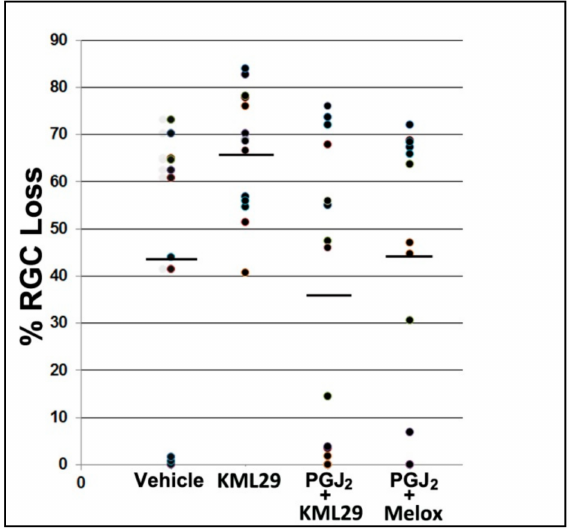
Figure 5. Stereological analysis of RGC loss following rAION induction and treatment. Scatter plot results of Brn3a(+) flat-mounted RGCs 30 d post-rAION induction. Each point represents the RGC loss from one animal compared with the contralateral (uninduced) eye (=100%). Mean RGC loss in the vehicle group was 44.0 ± 9.8% sem. KML29 treatment alone (no PGJ 2 coadministration) resulted in a statistically significant decrease in RGC survival (66.6 ± 3.7% sem; two-tailed t -test; p = 0.0275). There was no statistically significant improvement in RGC survival with PGJ 2 + KML29 (mean 36.6 ± 7.9 sem ( n = 16) vs. vehicle; 44.0 ± 9.8 sem ( n = 11); two-tailed t-test; p = 0.5651), or with PGJ 2 + the COX inhibitor meloxicam (Melox) (44.6 ± 9.0 sem ( n = 11) vs. vehicle, 44.0 ± 9.8